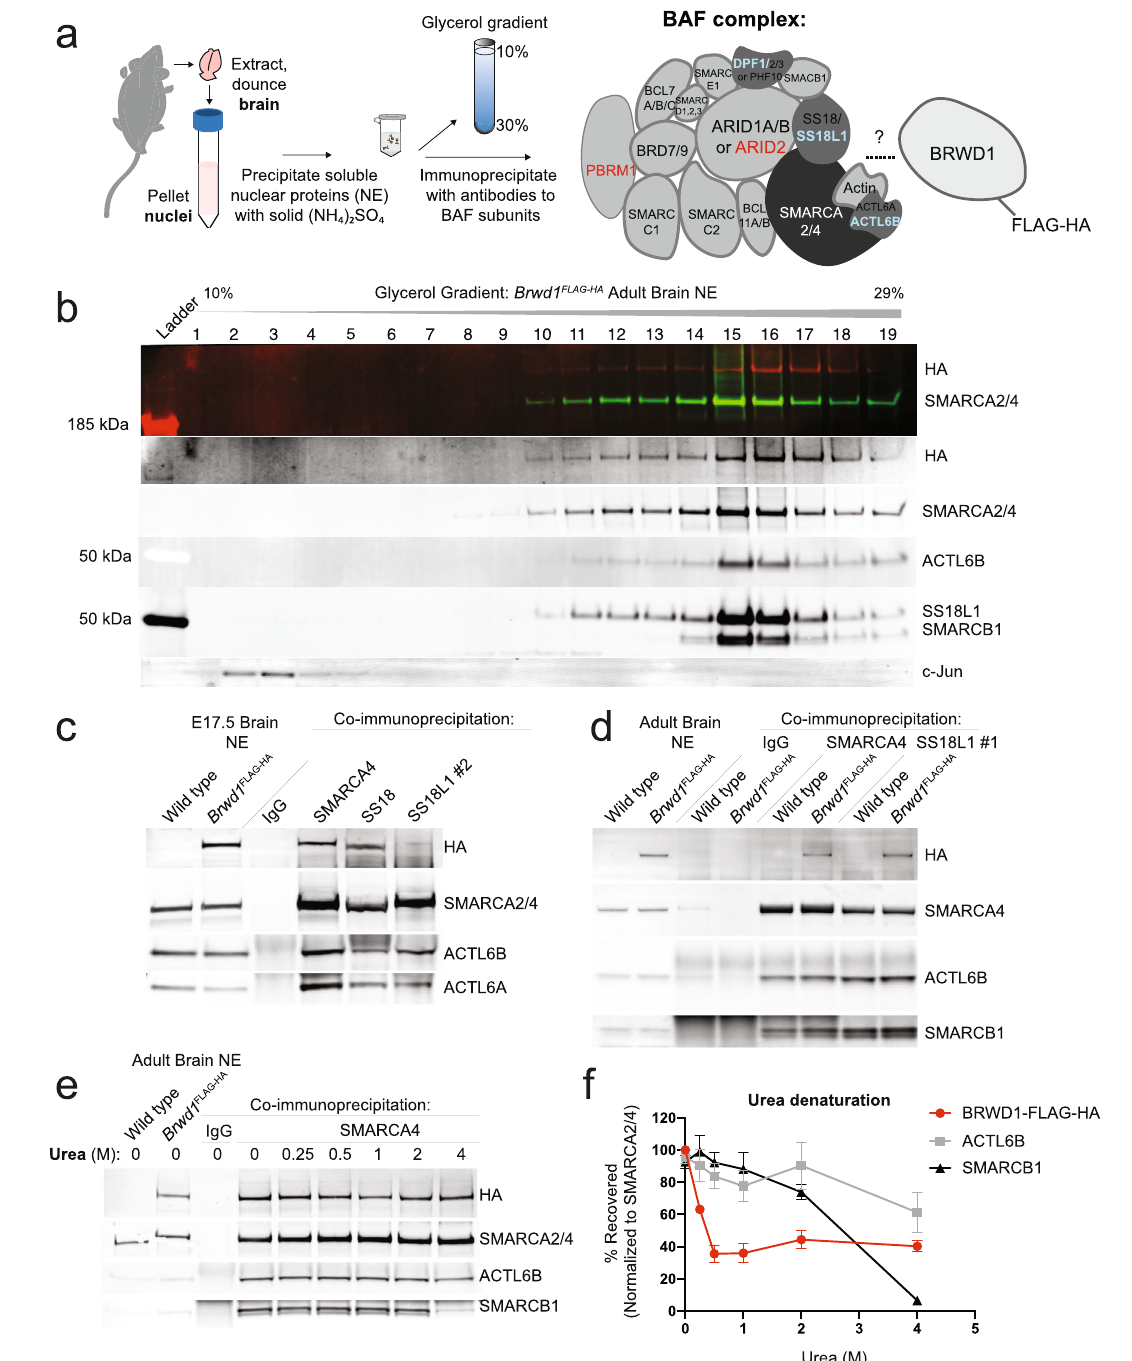
Fig. 3 | BRWD1 tightly associates with the BAF complex in euploid brain. a Schematic of mouse brain soluble nuclear protein extract (NE) preparation, density sedimentation of nuclear proteins over a 10 – 30% glycerol gradient, and immunoprecipitation of BAF chromatin remodeling complexes. Blue lettering indicates neuronal-speci fi c BAF subunits. Red lettering indicates PBAF-speci fi c subunits. b Density sedimentation of adult Brwd1 FLAG-HA brain NE over a 10 – 30% glycerolgradientindicatesthatBRWD1predominantlyassociateswithlargeprotein complexes. Subunits of BAF and AP-1 complexes serve as molecular weight mar- kers: SMARCA2/4 antibody indicates all BAF complexes including non-canonical GBAF (~1 MDa) 75 , canonical BAF (~2MDa) and Polybromo-containing BAF (PBAF, ~3MDa); ACTL6B and SS18L1 indicate neuronal-speci fi c BAF complexes; c-Jun indicates AP-1 (160 – 440kDa). HA signal at the expected molecular weight of BRWD1-FLAG-HA (~260kDa) is observed in fractions containing the BAF complex. c Endogenous BRWD1-FLAG-HA interacts with BAF complexes in embryonic brain.